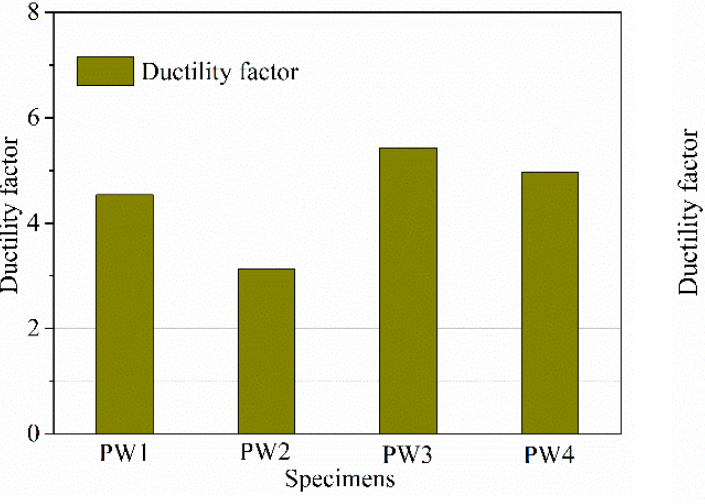
( d ) Figure 14. Force-strain hysteretic curves of T1-T4 for PW3: ( a ) T1 measure point; ( b ) T2 measure point; ( c ) T3 measure point; and ( d ) T4 measure point. As seen from Figure 14, the force–strain curves of the upper and lower rebars con- nected by grouted sleeves are relatively close and flat during the elastic stage. As the load repeats and increases, the strains of upper and lower reinforcements increase significantly and the differences between of them increase rapidly. Furthermore, the lower rebars’ strains increased drastically more than those of upper rebars. In this case, the lower rebars’ strains are much larger than those of upper rebars for specimens in ultimate state and the